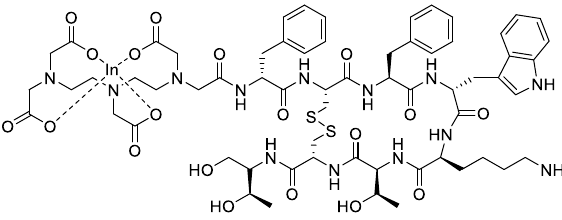
Figure 6. Structure of [ 111 In]-pentetreotide (Octreoscan ® ).